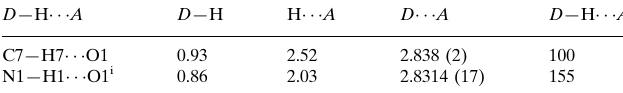
Hydrogen-bond geometry (A˚ , (cid:1)